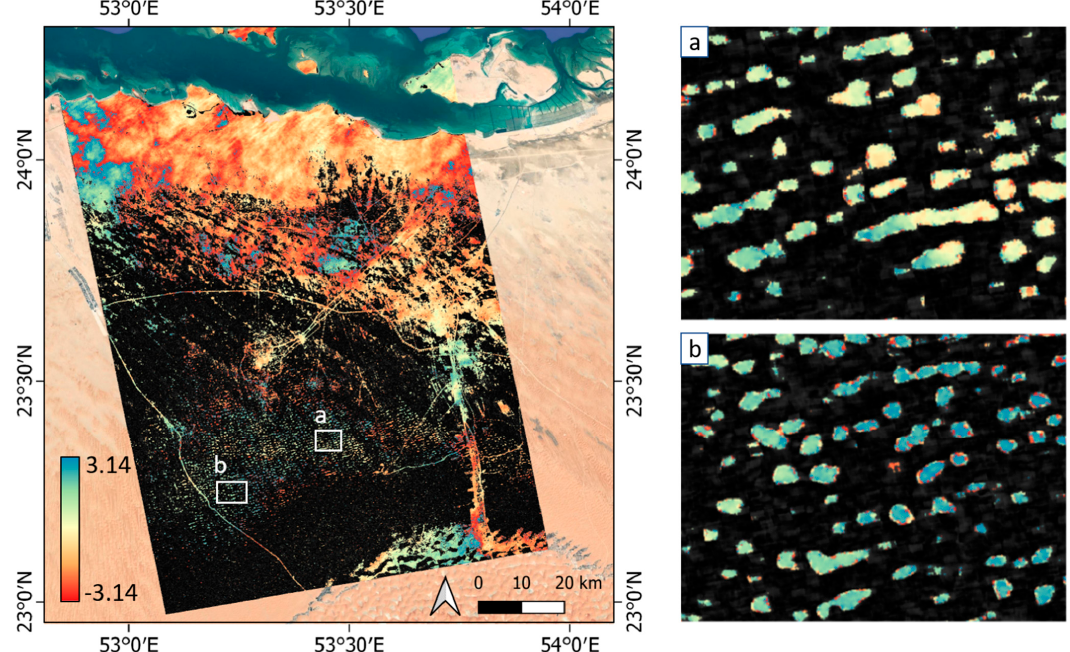
Figure 8. Interferometric phase map computed between 3 November 2018 and 15 November 2018 and detail of the two sub-areas a and b . The pixels having an absolute value of coherence lower than the noise threshold are masked (black pixels). Basemap: © Google 2019 Copyright.